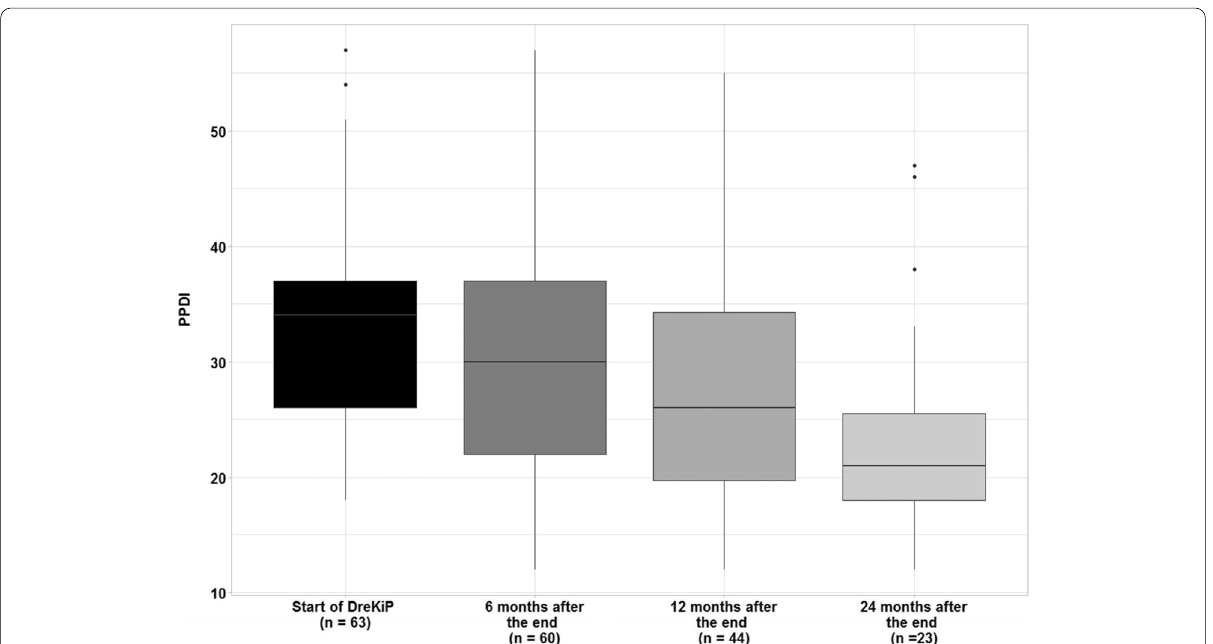
Fig. 7 PPDI. (Median) at baseline and follow up 6, 12 and 24 months after the program “DreKiP” (stands for Dresden children and adolescent headache